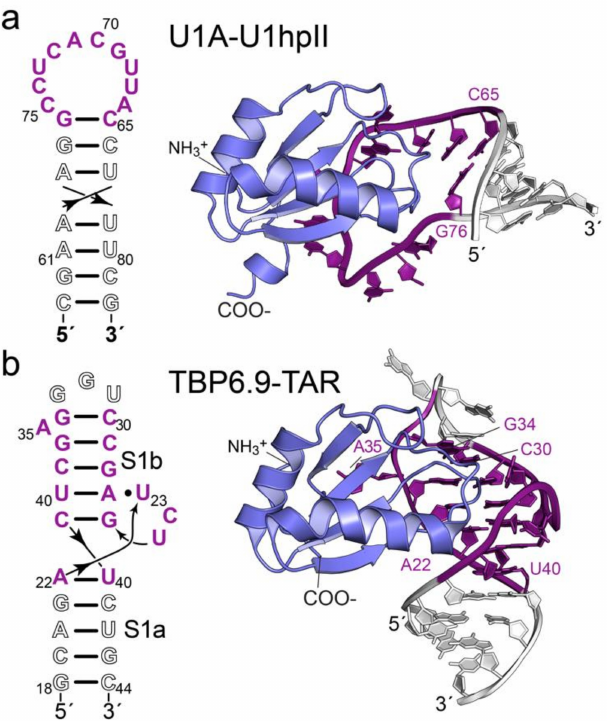
Figure 1. Schematic and cartoon diagrams of RNA sequences targeted by U1A and the related HIV TAR-binding protein (TBP) variant 6.9. ( a ) ( Left ) Human U1A RRM1 binds the short hair- pin II (hpII) sequence of U1 snRNA. Binding occurs primarily in the single-stranded loop region closed by the canonical C65-G76 base pair. This region is necessary and sufficient for U1A binding. ( Right ) Cartoon drawing of the double-mutant protein (dm)U1A-hpII 21-mer co-crystal structure [56], emphasizing protein recognition of the hpII loop (PDB entry 1urn); the duplex region (white) is not involved in hpII binding and can be replaced by a target sequence to promote RNA crystallization. ( b ) ( Left ) Lab-evolved TBP6.9 recognizes TAR RNA at the internal bulged loop, which includes a U23 A27-U40 base triple and bulged A35 within helical stem S1b [51,52]. An arginine fork is a key determinant of recognition at the G26 major-groove edge and the U23 backbone [59]. ( Right ) Cartoon drawing of the TBP6.9-TAR co-crystal structure [52], emphasizing protein recognition of the TAR in- ternal bulged loop (PDB entry 5xh0); the apical loop and S1a (white) are not involved in TAR binding and are hypothesized herein to allow replacement within a duplex target sequence to promote RNA crystallization and